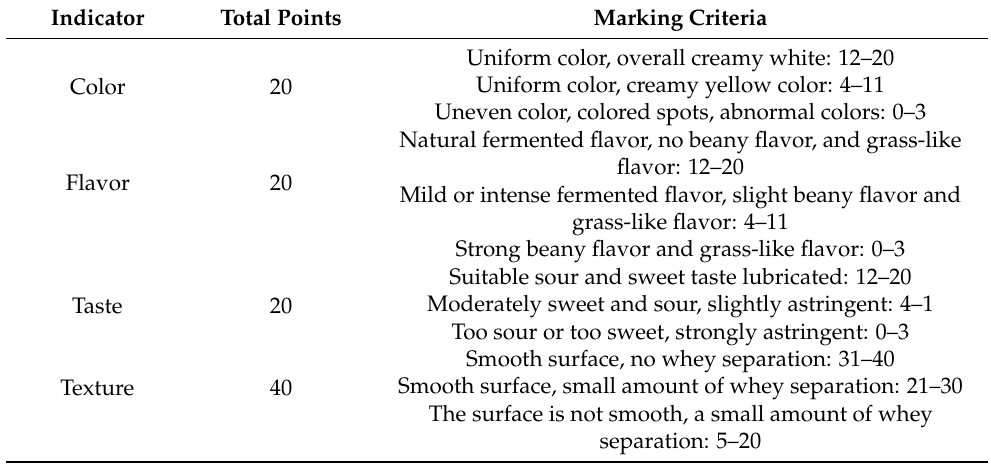
Table 4. Sensory evaluation scoring index and criteria of yogurt samples.